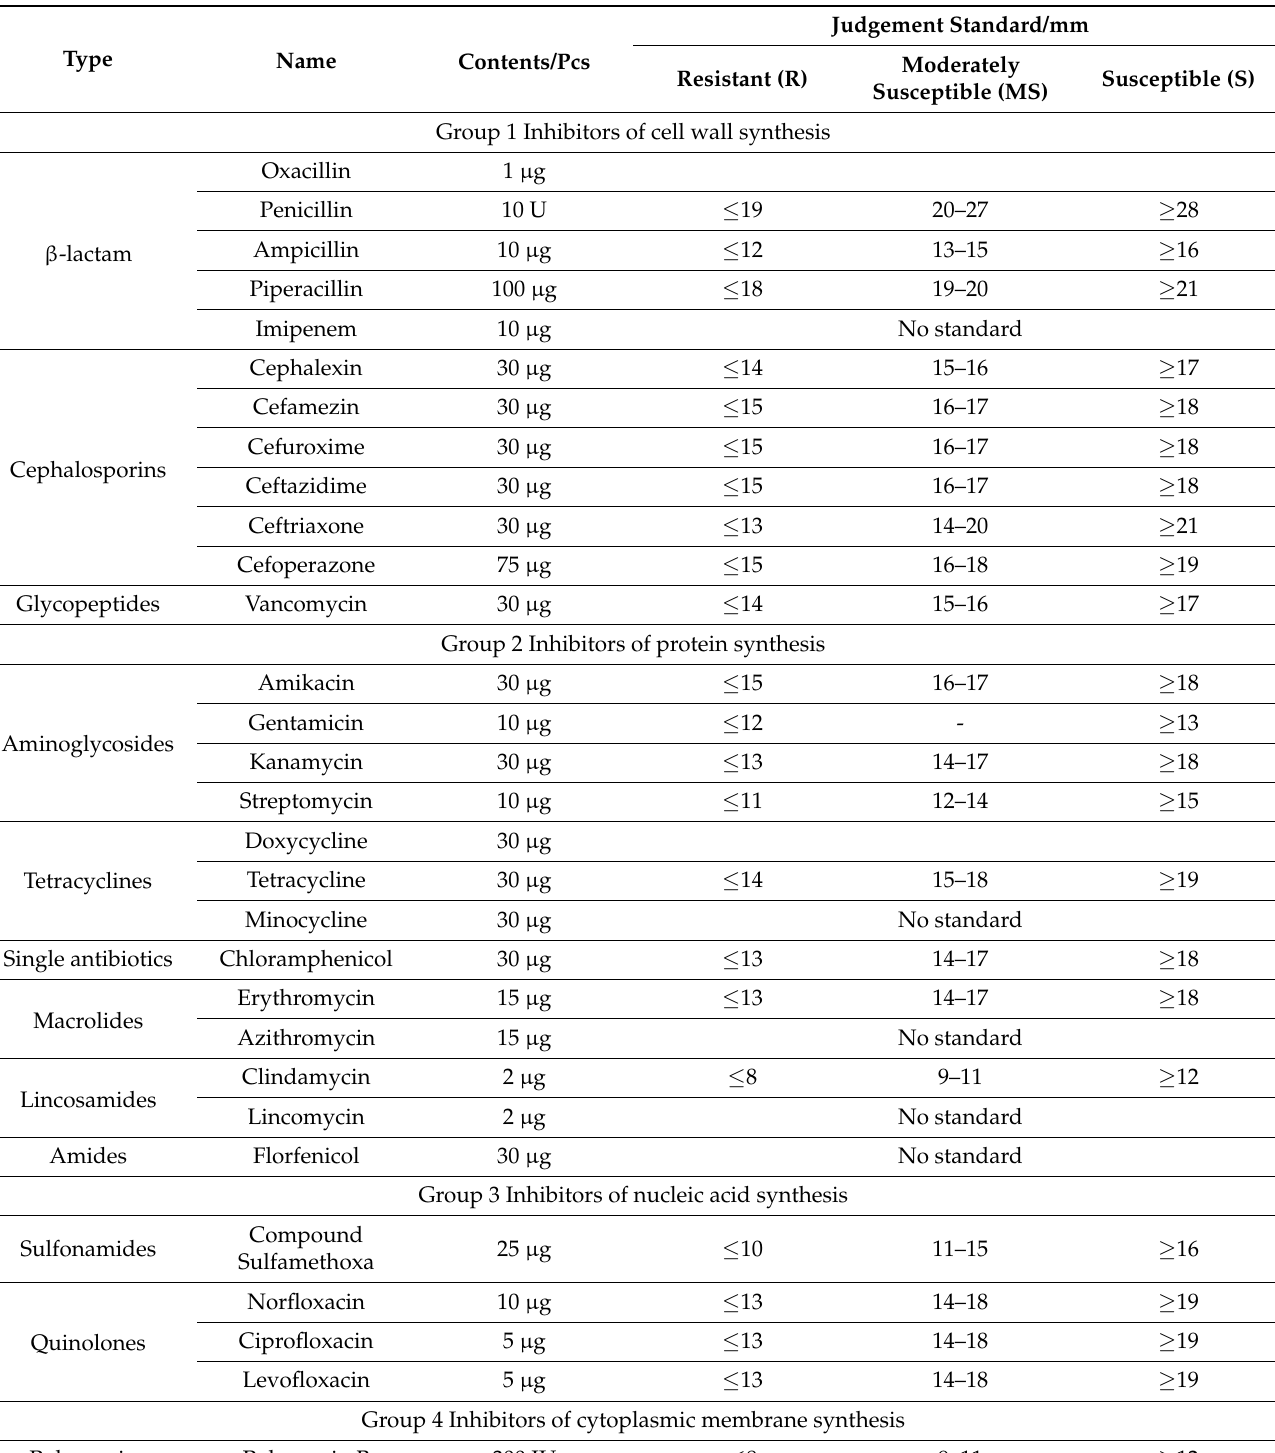
Table 1. Types, names, contents, and judgment standards of 30 kinds of